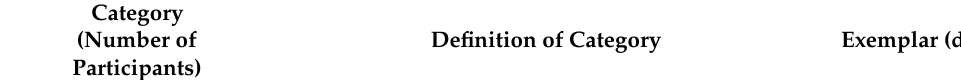
Table 2. Reasons for climate change (dis)-beliefs and disbeliefs among participants driving for TNCs (Transportation Net- work Companies). number of participants: n = 75.